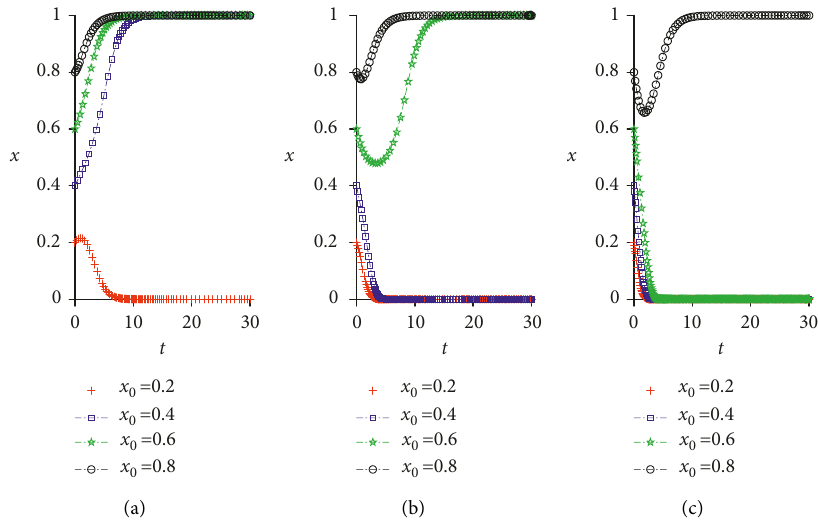
(innovation benefit of the client when it innovates in- ′